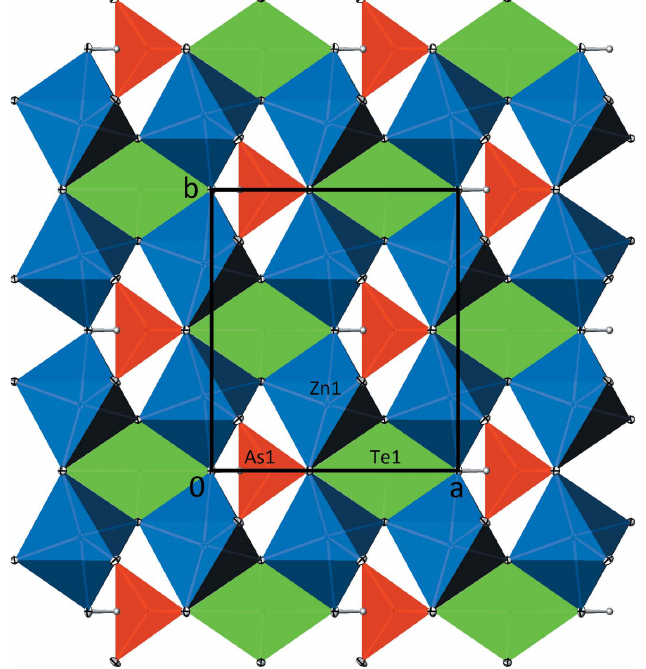
Figure 3 The crystal structure of Zn 2 (HTeO 3 )(AsO 4 ) in polyhedral representation, projected onto (001). [ZnO 4 OH] polyhedra are blue, [TeO 3 OH] polyhedra are green and [AsO 4 ] tetrahedra are red; H atoms are represented as grey spheres of arbitrary radius. Displacement ellipsoids are drawn at the 90% probability level.